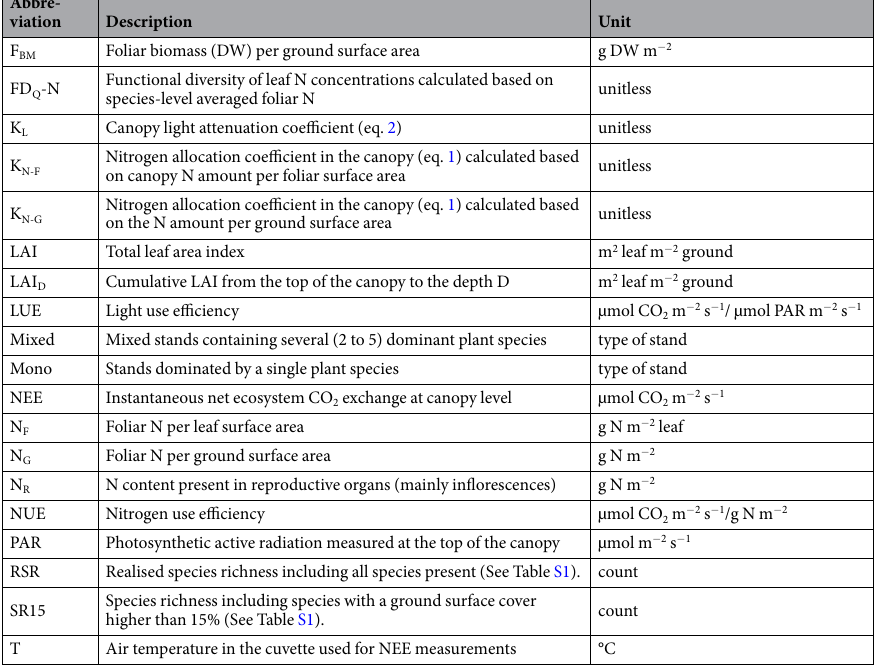
Realised species richness including all species present (See Table S1). count Species richness including species with a ground surface cover higher than 15% (See Table S1). Air temperature in the cuvette used for NEE measurements Table 1. Table explaining the most important